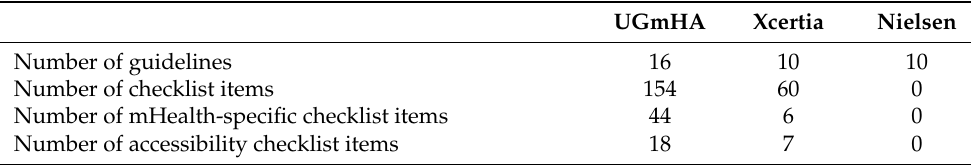
Table 14. Guidelines and checklist items of UGmHA, Xcertia and